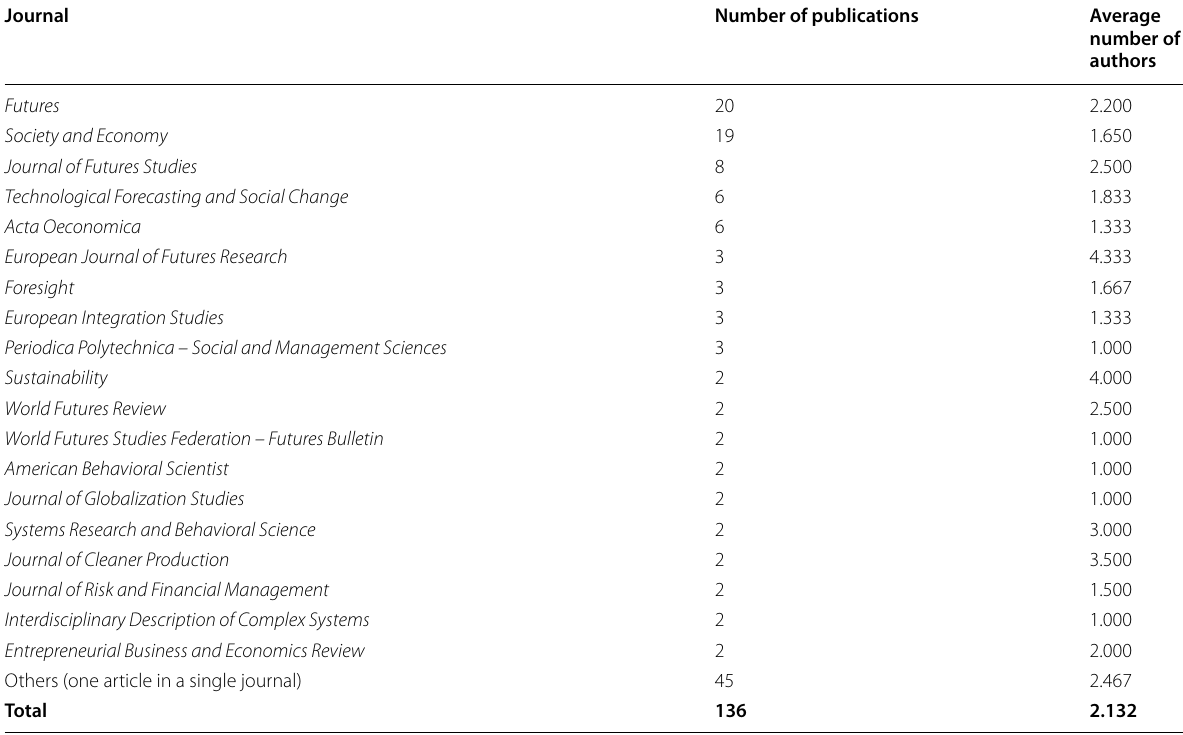
Table 4 Distribution of articles by the publication outlet